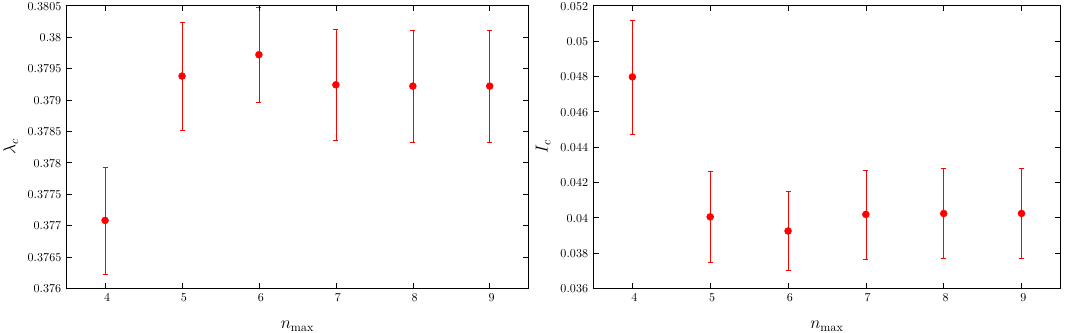
Figure 7 . Dependence of the fitted values of λ c (left) and I c (right) on the order of the polynomial in a constrained fit to the data for the spectral statistic I λ obtained at ¯ β = 5 . 75, using w = 0 . 06, N s min = 40 and σ =